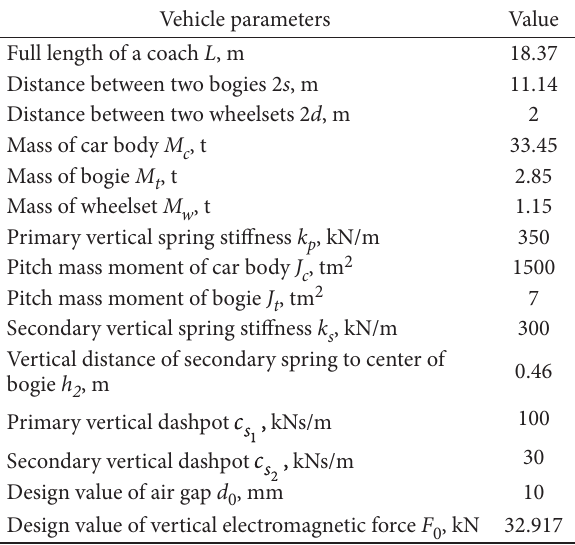
Table 1. Main calculation parameters of LIM vehicle